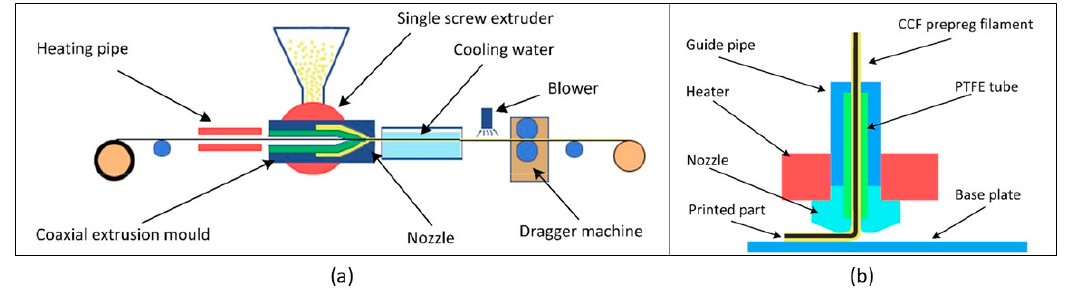
Figure 6. Schematic of ex-situ prepreg process: ( a ) The extrusion and cooling apparatus for production of the prepreg filament. ( b ) The printing process utilising the prepreg filament requires no drive gear